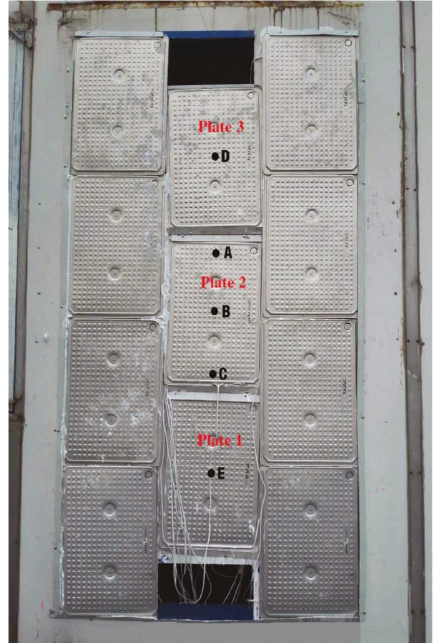
Figure 2: Arrangement diagram of PCM plate array and thermocouples.